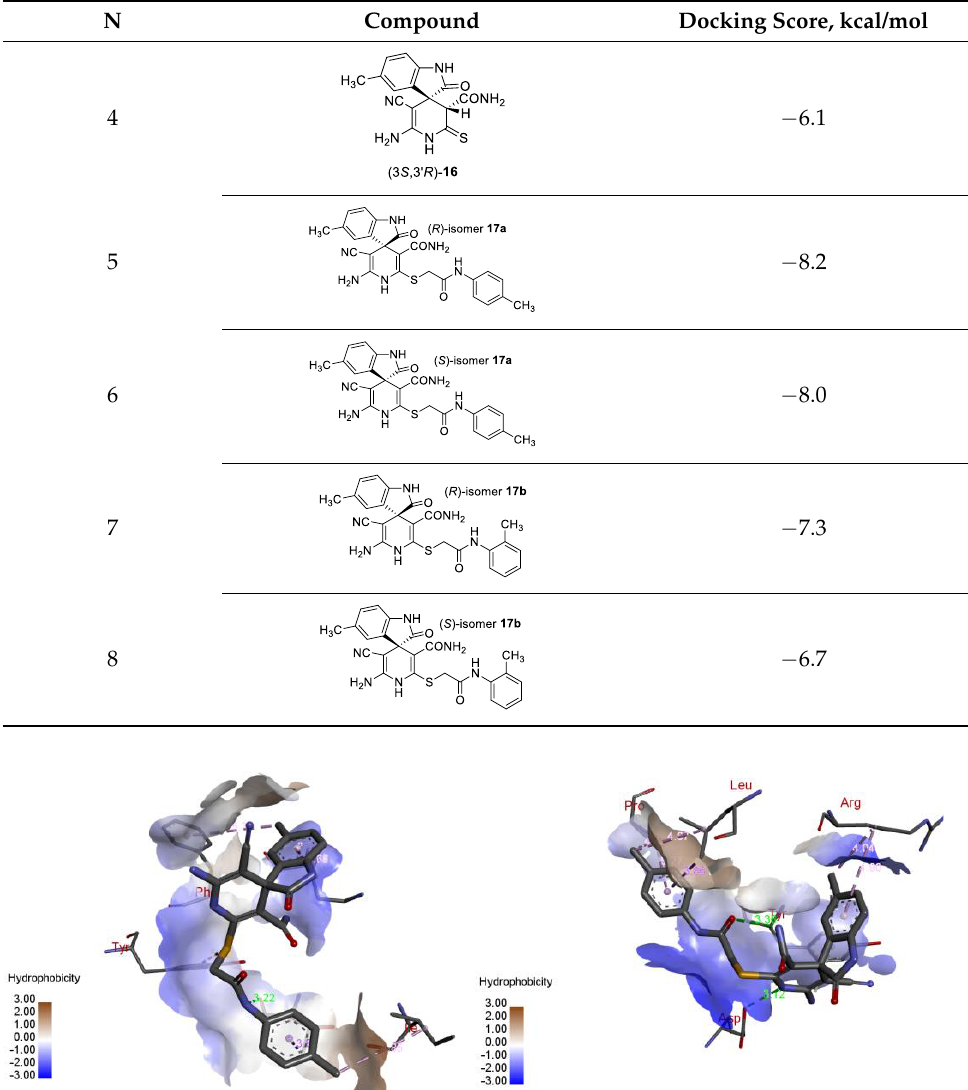
Figure 1. Best-scored docking poses for ( R )- 17a ( left ) and ( S )- 17a ( right ) with bacterial protein PqsR (PDB ID 4JVC) (dotted lines show non-valent contacts of the ligand with amino acid residues of the target protein PqsR).